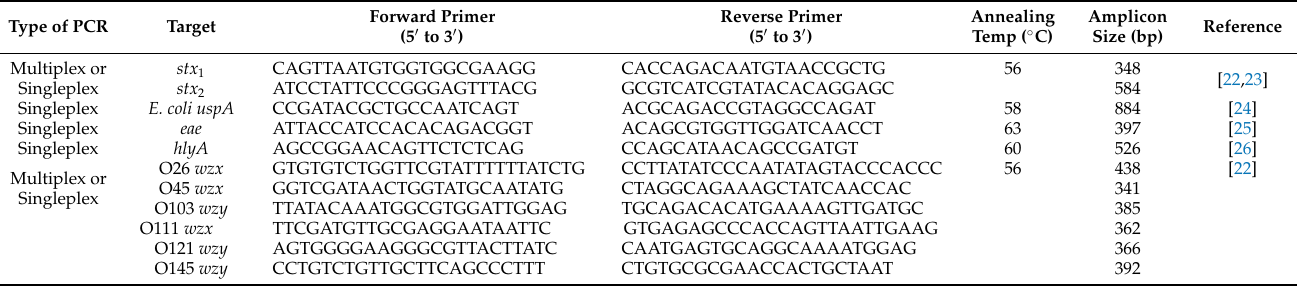
Table 1. Primers used for detection and characterization of STEC